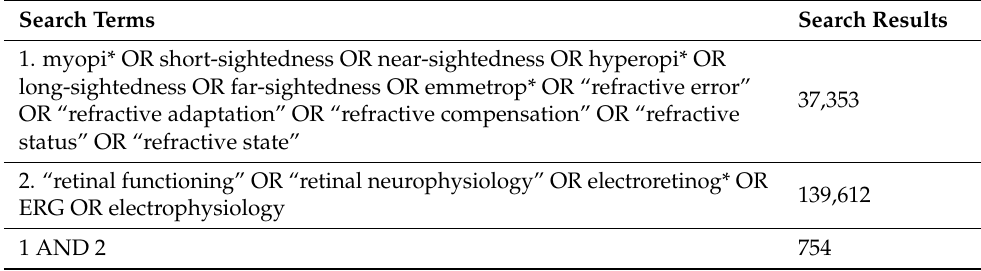
Table 1. Database Search Strategy and Example Results from